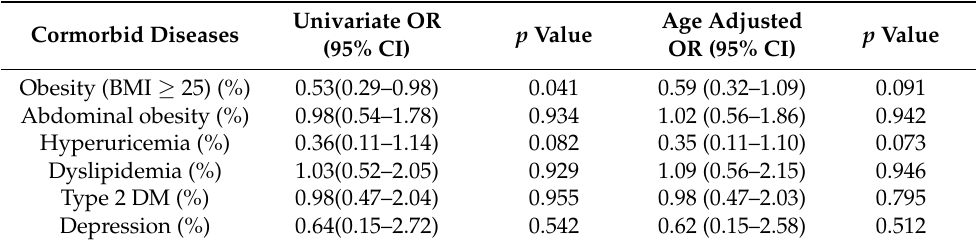
Table 4. Logistic regression analysis of comorbid diseases with osteoporosis adjusted by age in male subjects.